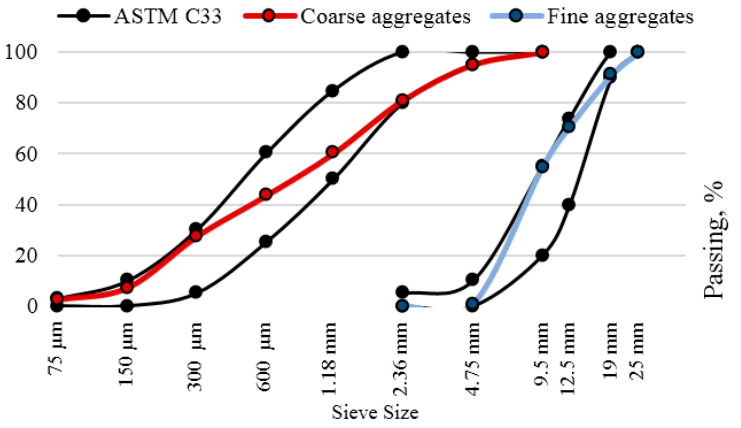
Figure 4. Particle size distribution of aggregates.